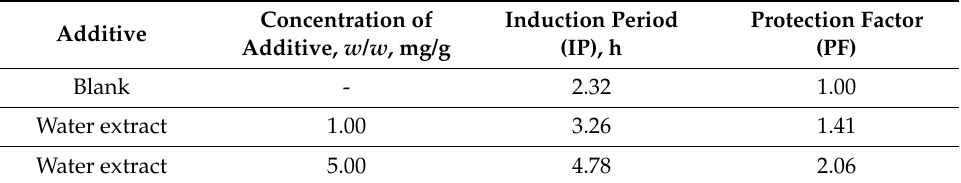
Table 3. Black alder bark accelerated solvent extraction with deionized water comparative effect on the stability of mayonnaise.